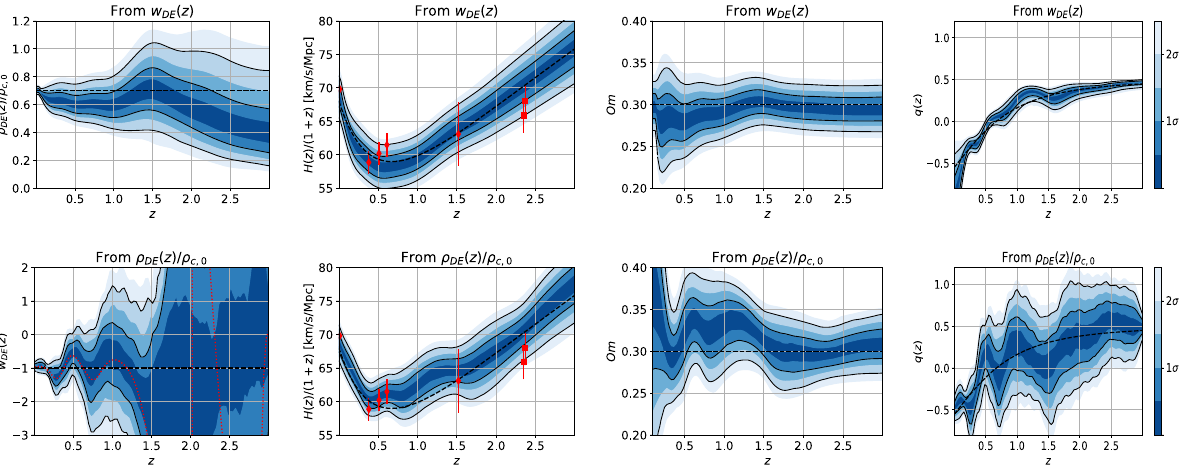
Fig. 6 Derived functions for the reconstructed w DE ( z ) and ρ DE ( z )/ρ c , 0 with 20 bins plus correlation function. The red dotted line in the derived w ( z ) corresponds to the best-fit DE